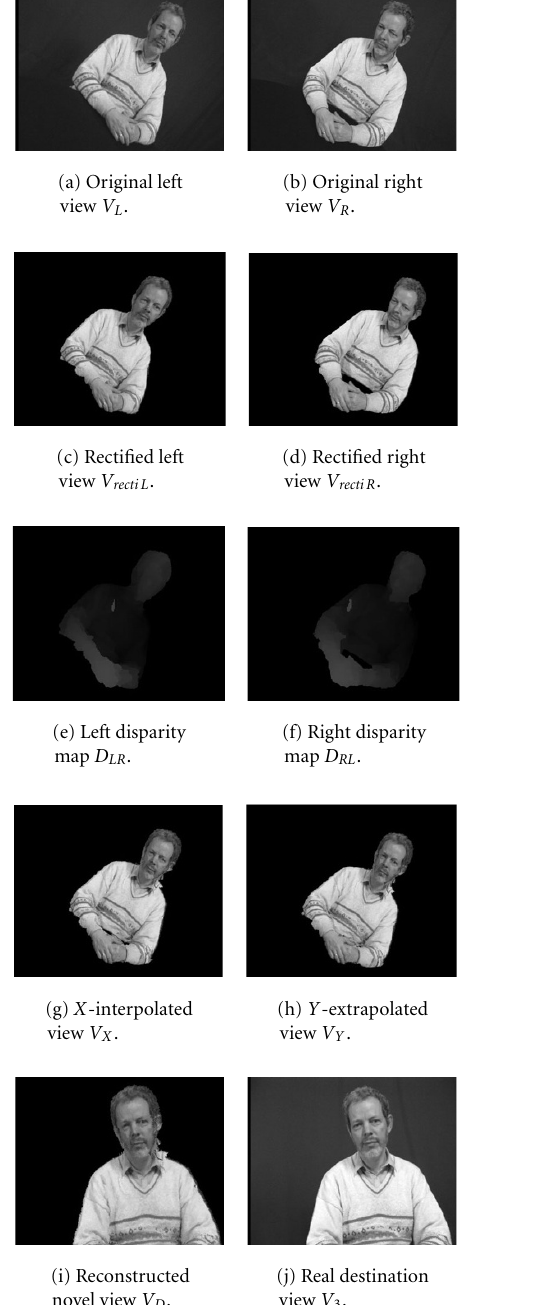
Figure 14: All intermediate and final results from our multi-step view reconstruction algorithm are listed above together with the disparity data. They are based on a pair of stereo frames ((a) and (b)) from the setup shown in Figure 13 with a di ff erent talking per- son as the participant.